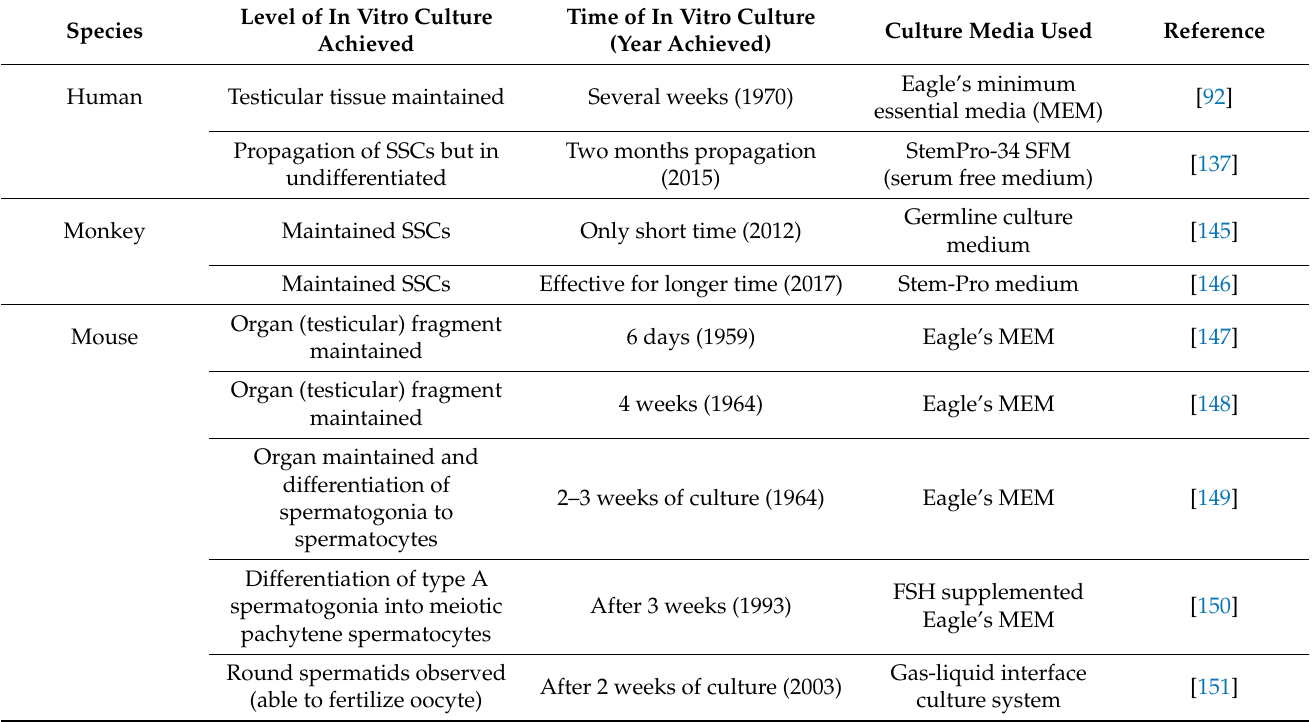
Figure 2. Schematic illustration of spermatogonial stem cells (SSCs) as treatment option for male infertility, ( A ) Transplan- tation of SSCs into infertile testis after in vitro propagation, ( B ) Application of spermatozoa in intracytoplasmic sperm injection after in vitro spermatogenesis of SSCs. Table 1. Milestone and trends of using spermatogonial stem cells to treat impaired spermatogenesis and non-obstructive azoospermia in different species.